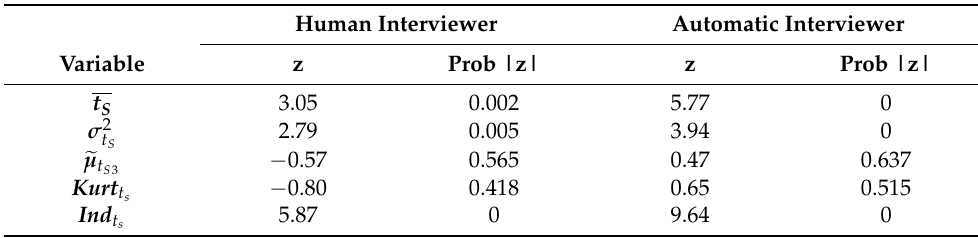
Table 5. Results of Wilcoxon Summation Test.